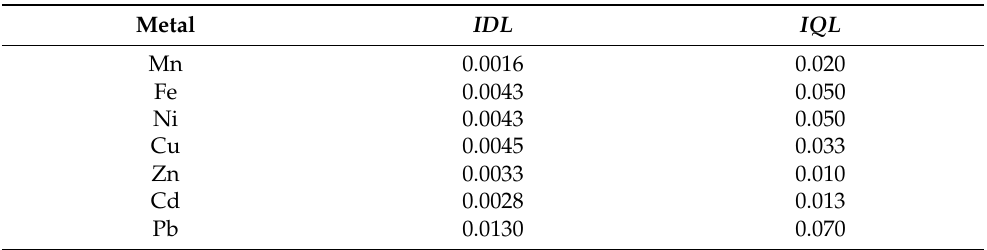
Table 1. The instrumental detection limits ( IDL ) and instrumental quantification limits ( IQL ) for the spectrometer iCE 3500 [mg/dm 3 ]